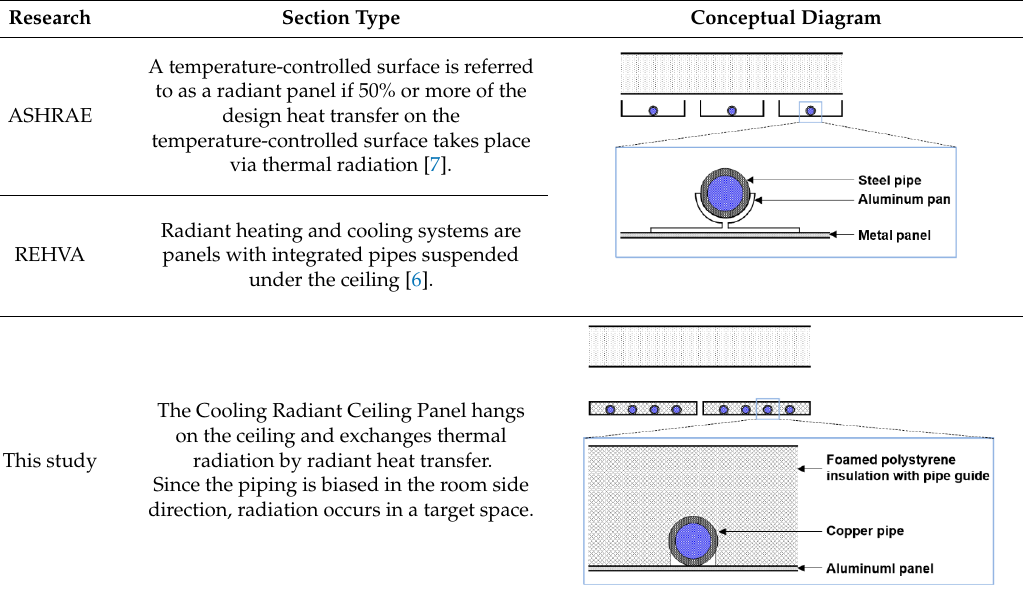
Table 1. Type of Cooling Radiant Ceiling Panel.